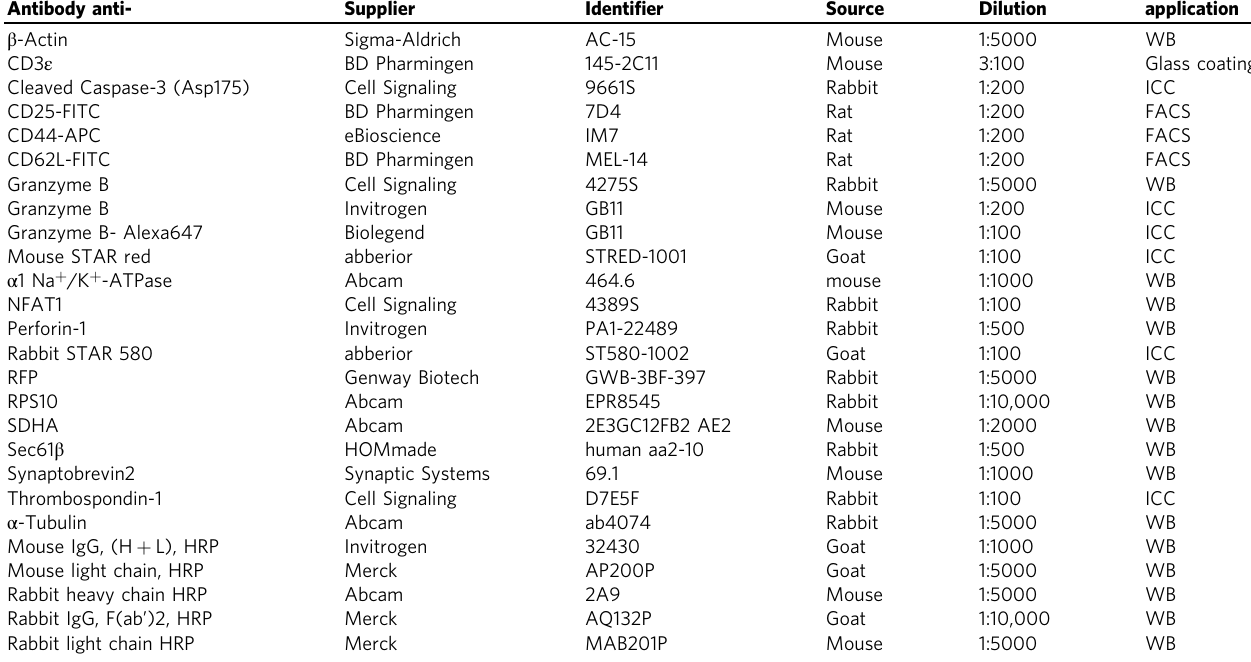
Table 1 Antibodies used in this study. Antibody